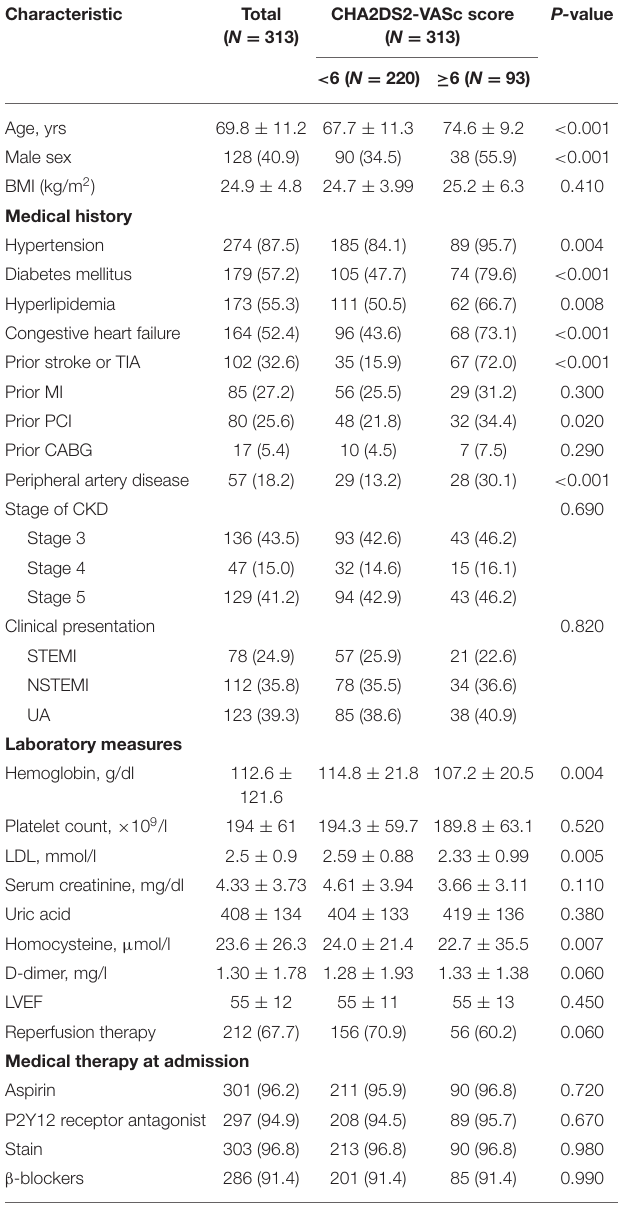
TABLE 1 | Baseline characteristics in CKD patients hospitalized with ACS by CHA2DS2-VASc score. Characteristic